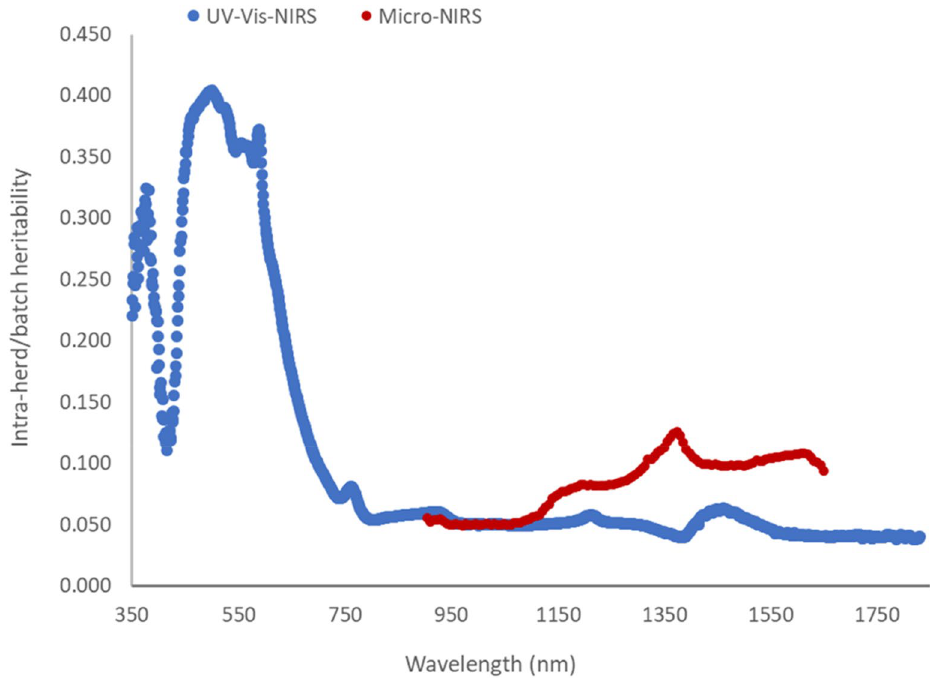
Figure 4. Intra-herd/batch heritability of absorbance of each individual wavelength of the spectra. Intra-herd/ batch heritability of absorbance of each individual wavelength of the spectra taken on the 5–6th rib cross- sectional area of longissimus thoracis muscle.